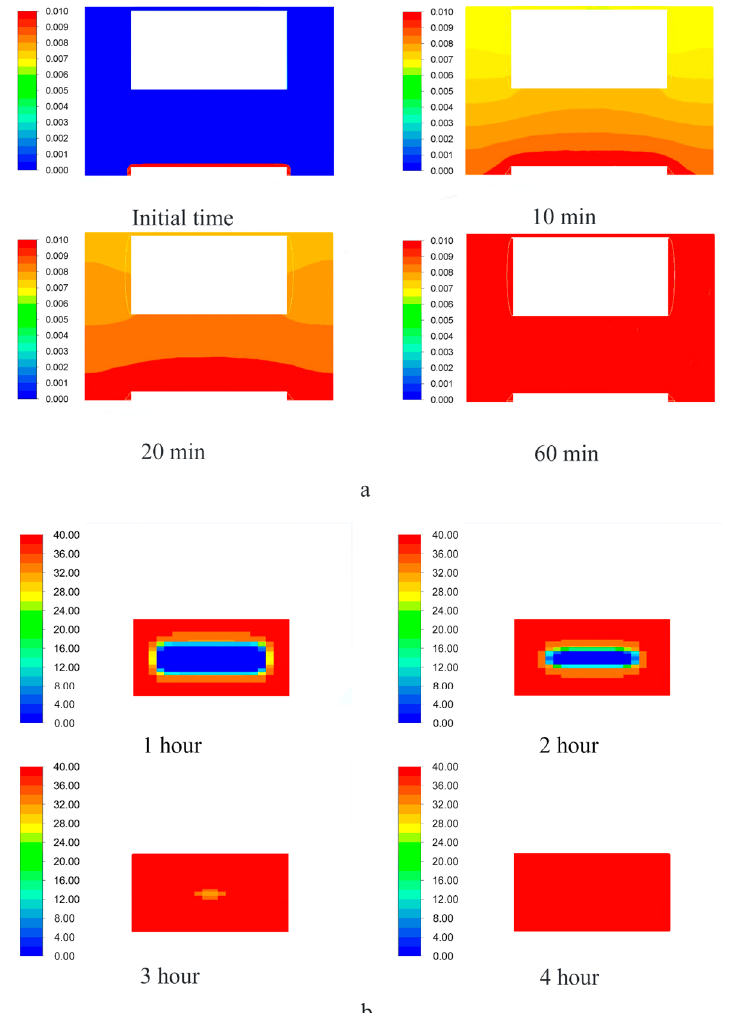
Figure 7. The distribution of the content of the active substance in the free volume of the reactor ( a ) and total amount of adsorbed active substance inside the porous body (aerogel) ( b ) at P = 140 bar and T = 323 K.